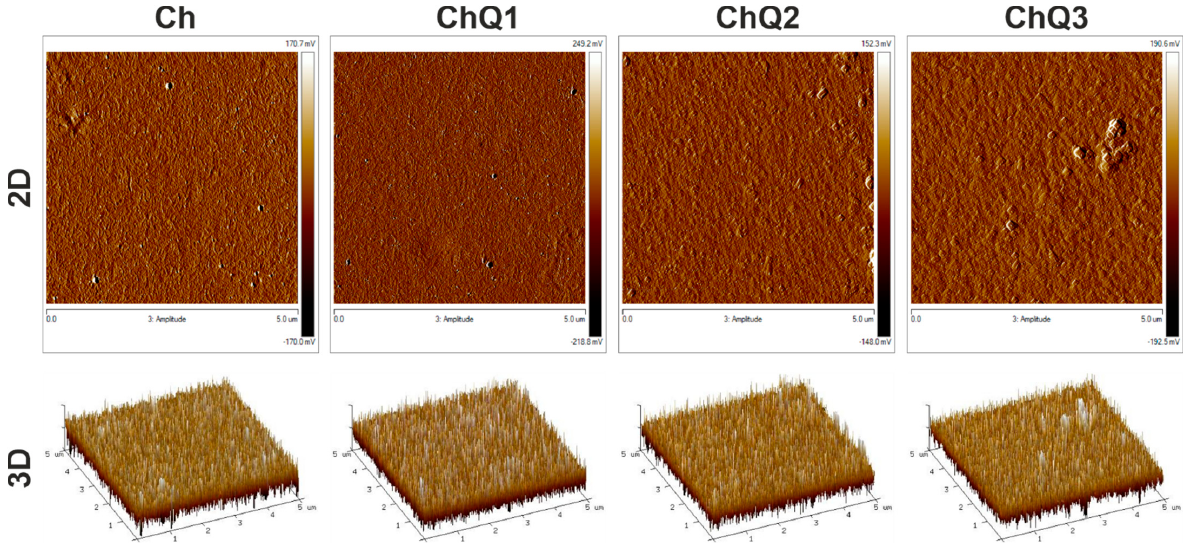
Figure 7. 2D and 3D atomic force microscopy (AFM) images of the surface topography of Ch and ChQ films. To determine the impact of squaric acid addition on chitosan films, pure chitosan film was used as a control sample. In particular, the influence of the amount of squaric acid on surface parameters was tested. As it can be seen (Figure 7), the AFM images do not reveal differences in the surface properties of films in the case of a pure chitosan film compared to crosslinked films. Two-dimensional images indicate the homogeneity of each tested sample consisting of chitosan and squaric acid. An imperfection was observed in the 2D image of chitosan with the 3 wt.% addition of squaric acid (Figure 7: ChQ3). This can either result from a contamination of the sample or suggest that chitosan and squaric acid solutions are not always uniformly miscible. Table 2. Values of roughness root mean square roughness (R q ) and roughness average (R a ) param- eters and thermal stability of studied materials. Sample